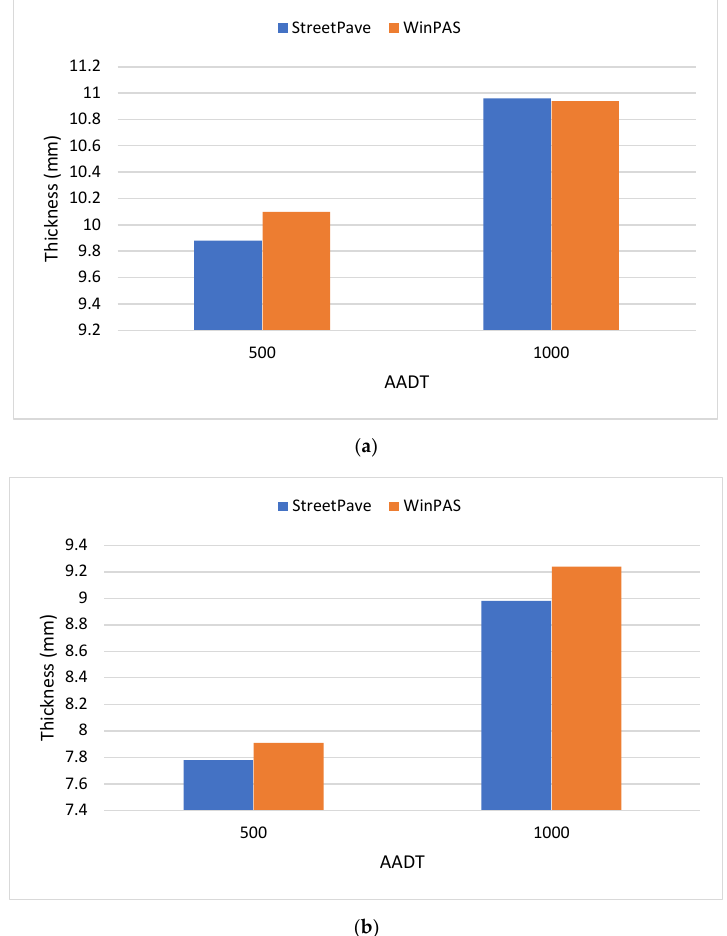
Figure 3. Comparison of WinPAS/StreetPave software for asphalt pavement. ( a ) Low subgrade strength. ( b ) High subgrade strength.